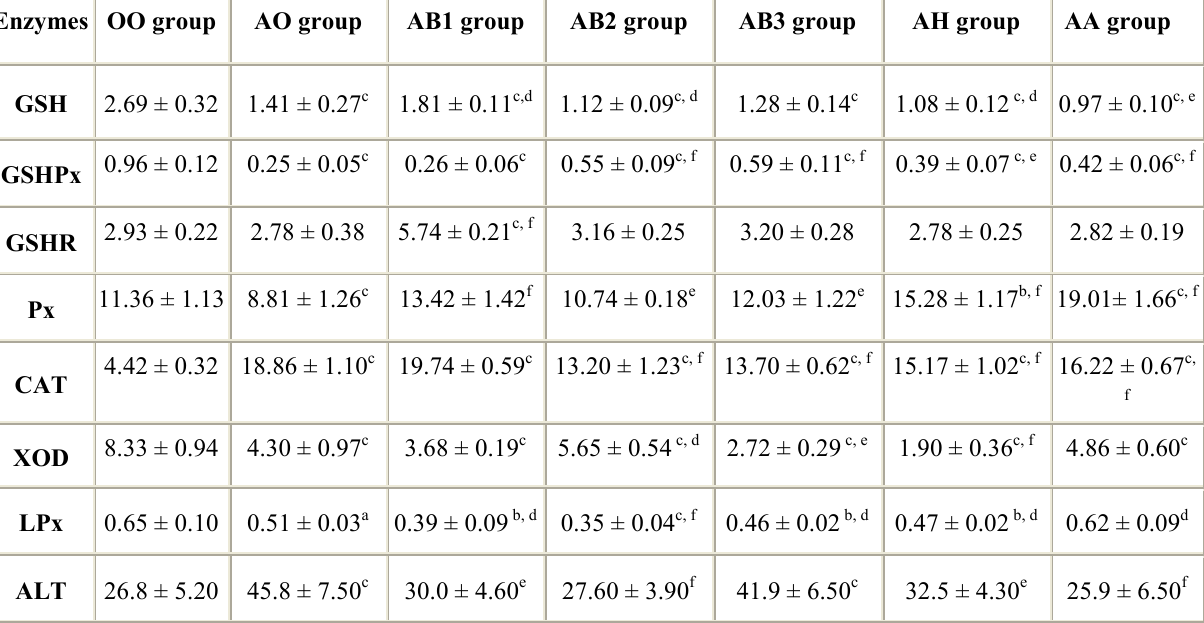
Table 1. Investigated biochemical